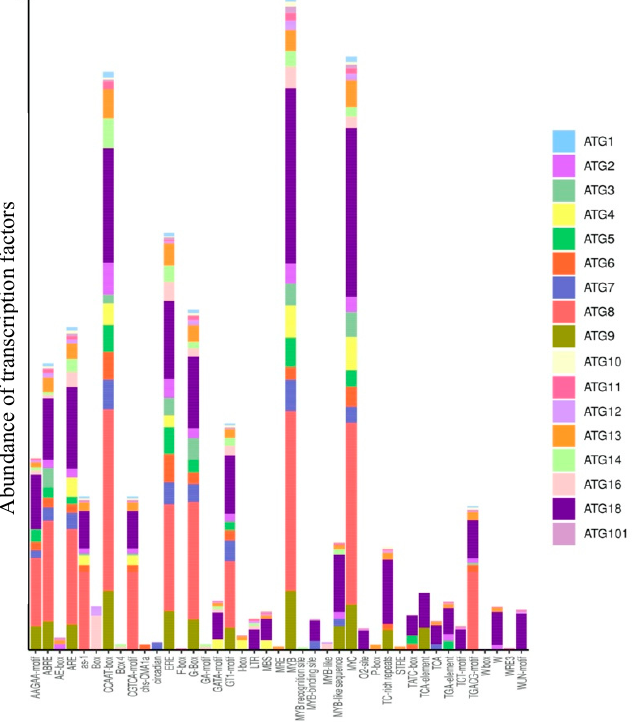
Figure 4. Transcription factor-binding sites in the promoter regions of ATGs (2000 bp) identified using PlantCARE.